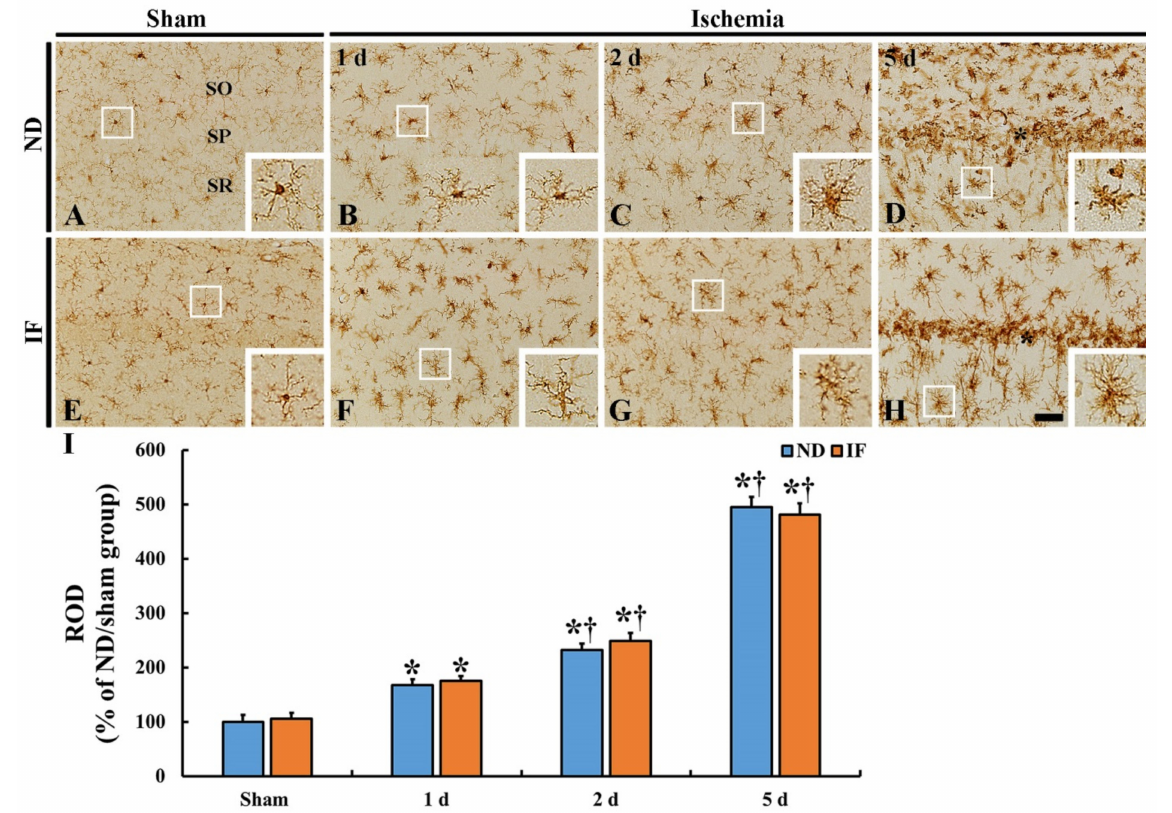
Figure 6. Ionized calcium-binding adapter molecule 1 (Iba-1) immunohistochemistry in the CA1 region of the ND (upper column) and IF (lower column) groups at sham ( A , E ), 1 day ( B , F ), 2 days ( C , G ) and 5 days ( D , H ) after ischemia. In both of the groups, Iba-1 immunoreactivity is significantly increased with time following ischemia, showing no difference in the immunoreactivity between the two groups. Note that Iba-1 immunoreactive cells are numerous near the stratum pyramidale (SP) (asterisk), in which pyramidal neurons are dead. Scale bar = 50 µ m. ( I ) Relative optical density (ROD) of Iba-1 immunoreactivity as percent values in the CA1 region ( n = 7 in each group, * p < 0.05 vs. ND/sham group, † p < 0.05 vs. pre-time point group of each group by post hoc Tukey’s test). Bars indicate the means ± SEM. IF, intermittent fasting; ND, normal diet; SO, stratum oriens; SR, stratum